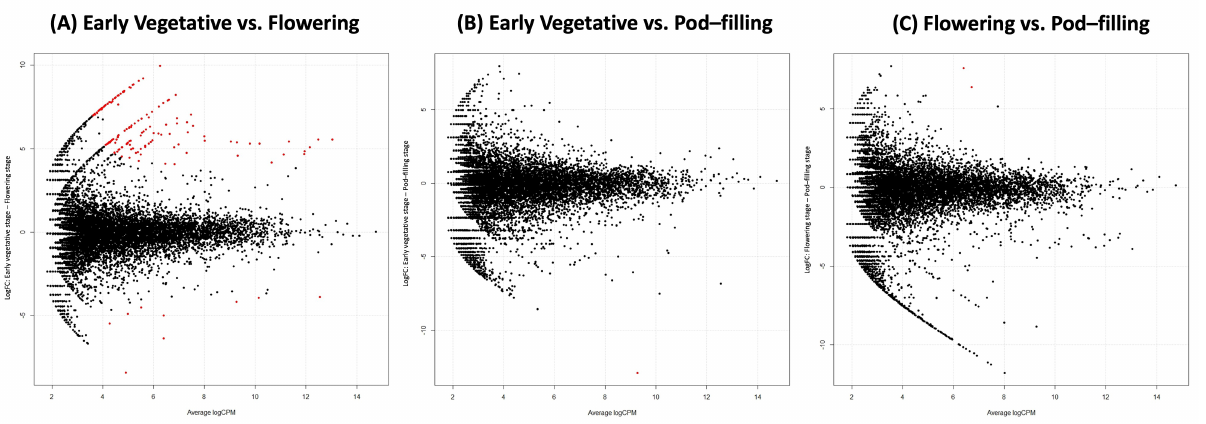
Figure 4. Differentially abundant operational taxonomic units (OTUs) in the rhizosphere of field- grown common bean ( P. vulgaris ) plants at three ontogenetic stages. The plots indicate the average log CPM (counts per million) and the log2 FC (fold change) of all OTUs comparing ( A ) the vegetative versus the flowering stage ( B ) vegetative versus pod filling stage and ( C ) flowering versus pod-filling stage, red dots indicate the significantly enriched OTUs (fold change > 2 and p < 0.05, FDR